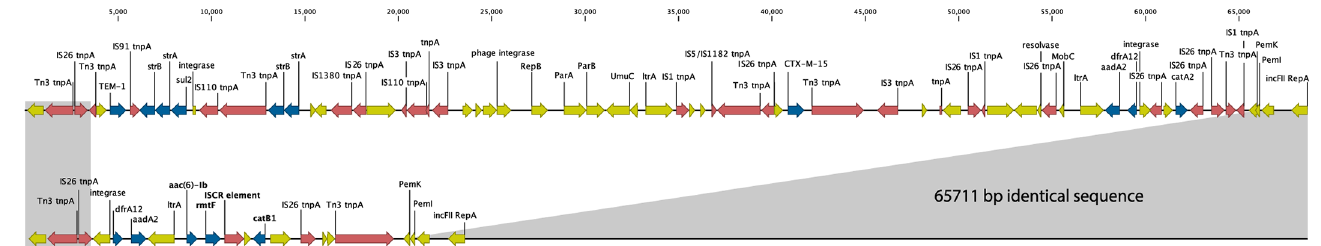
Fig 2. Comparison of resistance cassettesbetween pDA48896_1 and pMS6671_E. Resistance genesare depicted in blue, mobilegenetic elementsare depicted in red, surroundingproteinscoding genesare depicted in yellow. The shaded areas depict identicalsequencesflanking the variableregion. The plasmidscontaina backboneof 69 kbp of highly similar sequenceonly shown for pMS6671and not drawn to scale.